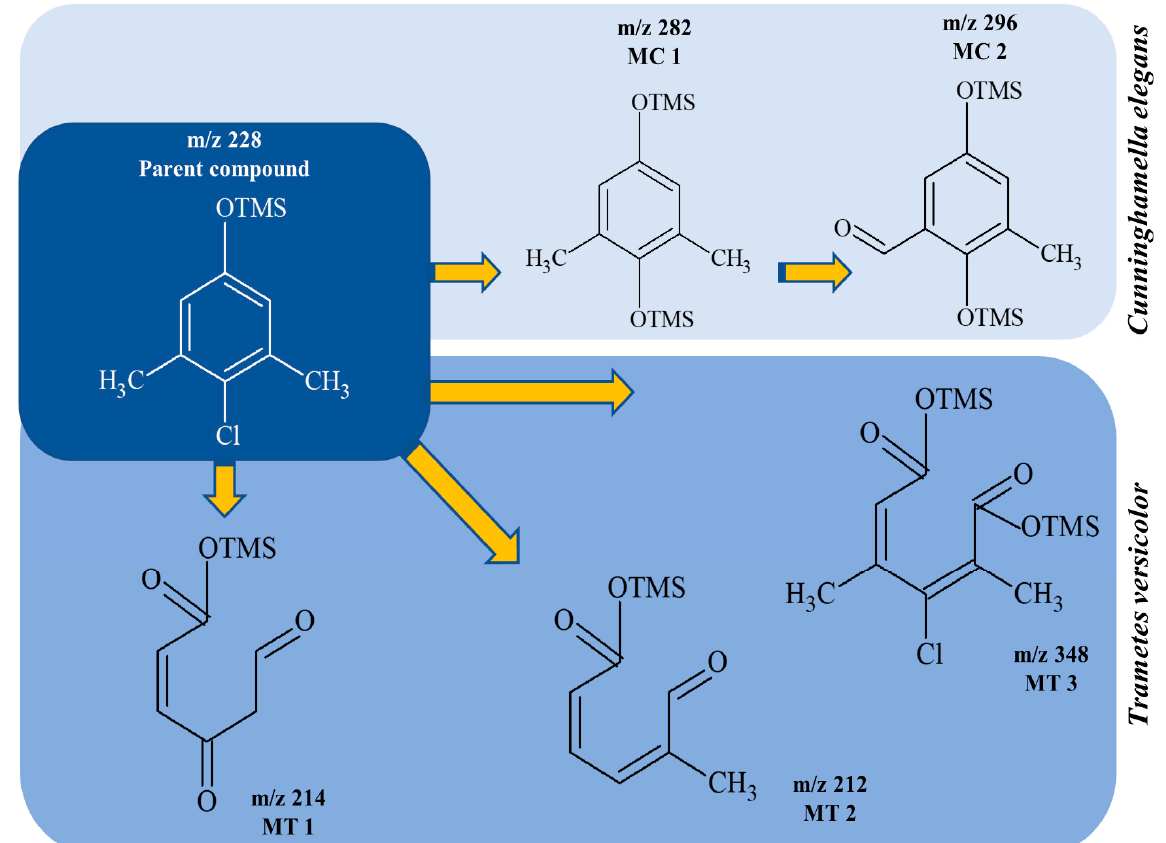
Figure 2. The chemical structure of chloroxylenol by-products formed by the tested strain.